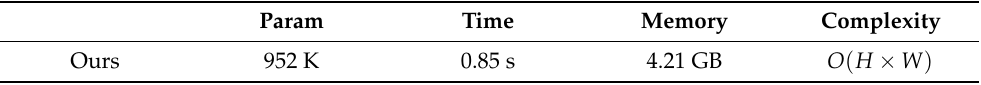
Table 4. Complexity and computational